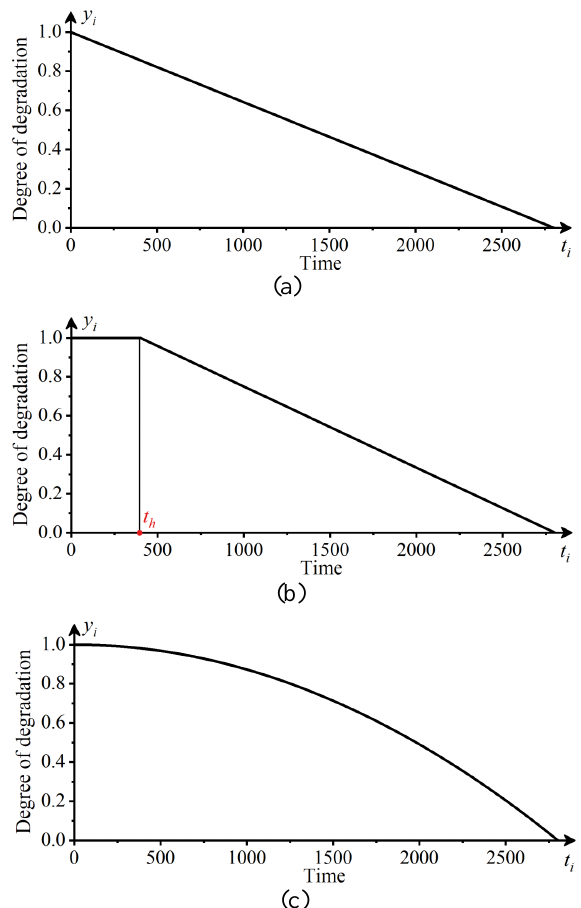
Figure 4. Three degradation label construction methods. ( a ) Linear degradation method. ( b ) Piece- wise smoothing method. ( c ) Quadratic function